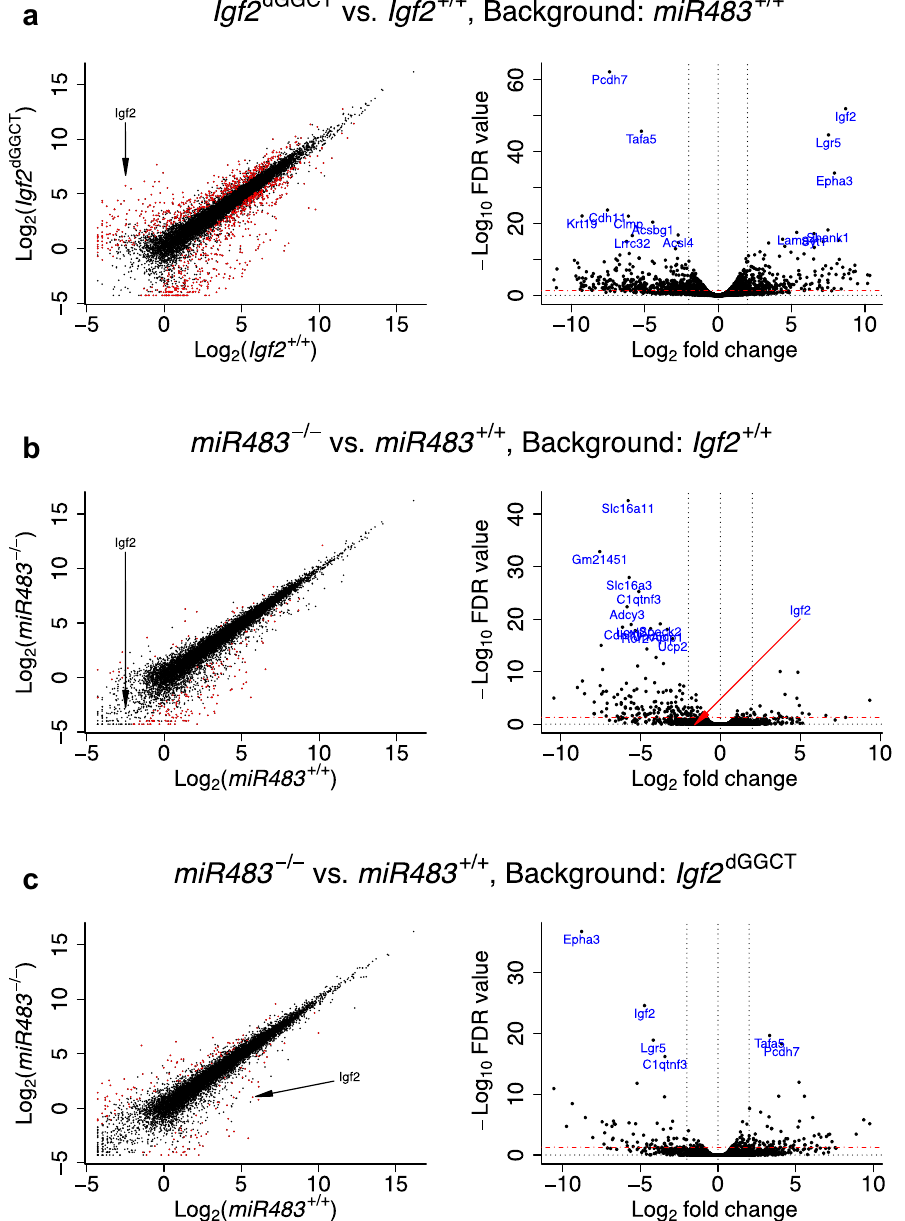
Figure 3. Results of RNA-seq analysis comparing Igf2 +/+ , Igf2 dGGCT , miR483 +/+ and miR483 −/− C2C12 cells. Scatter plots of RNA-seq expression levels in the log 2 scale between the different contrasts (left), and volcano plots showing the log 2 fold-change and the -log 10 FDR values (right). Expression values are the averages of two samples per cell type. Statistically significant differentially expressed genes with log 2 FC > 2 and -log 10 FDR > 1.3 are plotted in red in the scatter plots, and -log 10 FDR > 1.3 are indicated by a horizontal dashed red line in the volcano